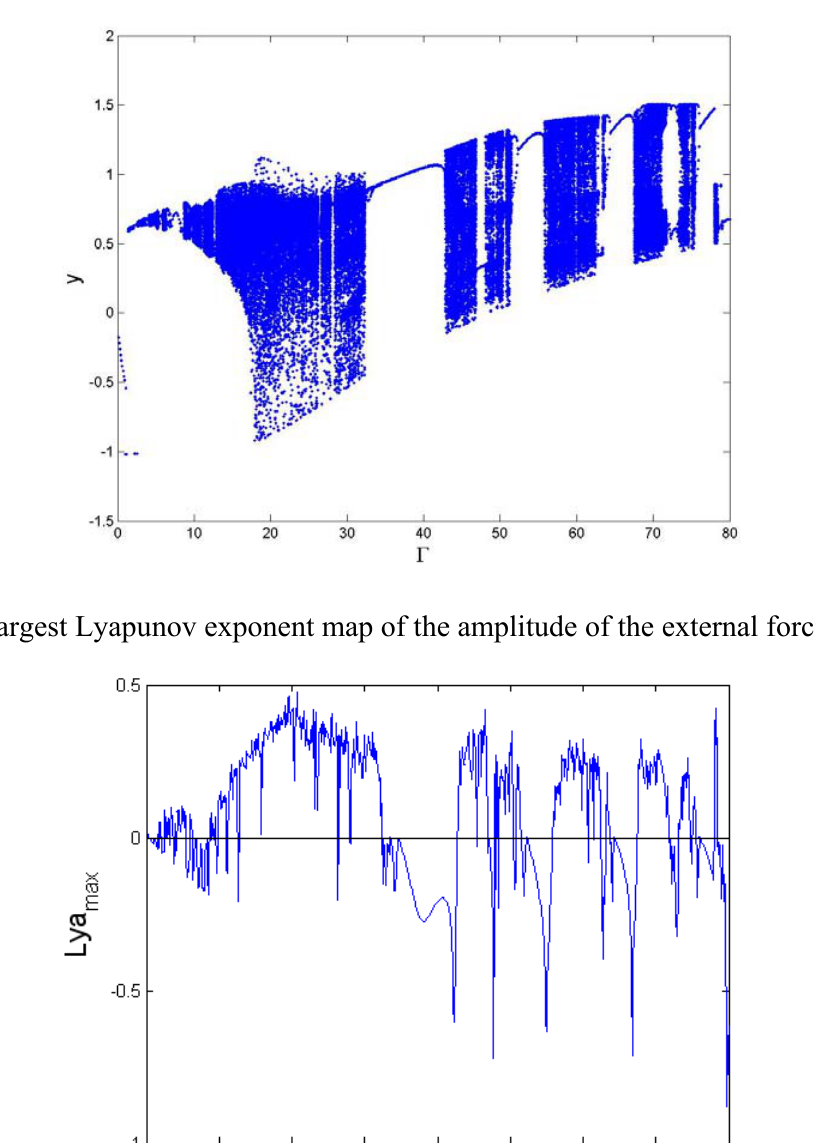
Figure 3. Bifurcation diagram of the amplitude of the external forcing term Γ .